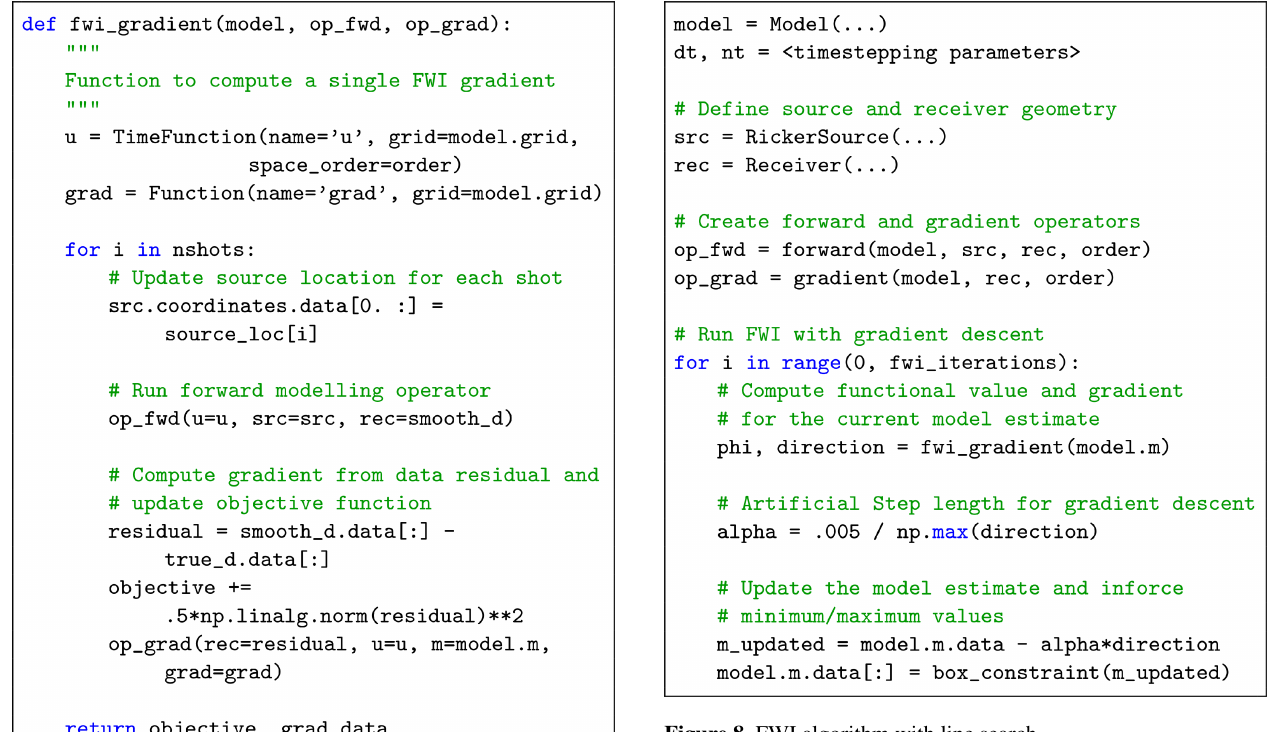
Figure 8. FWI algorithm with line